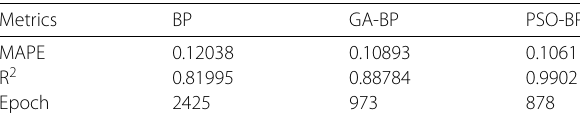
Table 4 Performance comparison of prediction